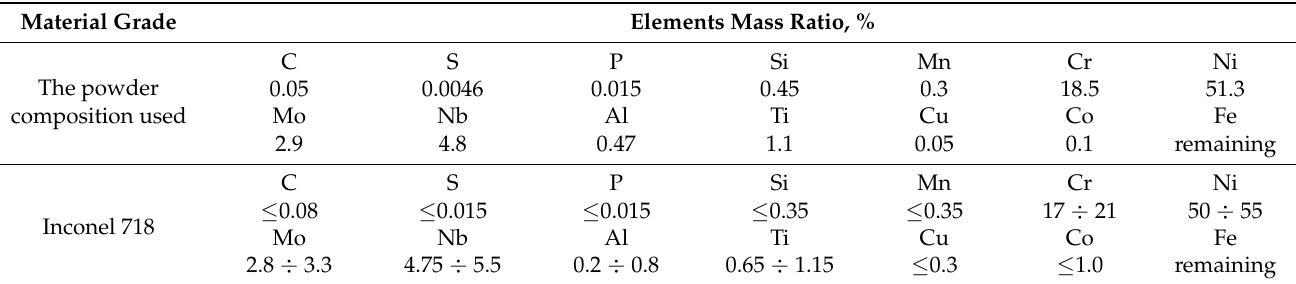
Table 1. The chemical composition of the researched materials (mixture of the powders, which was alloyed during the selective laser melting (SLM)) and the IN718 alloy.